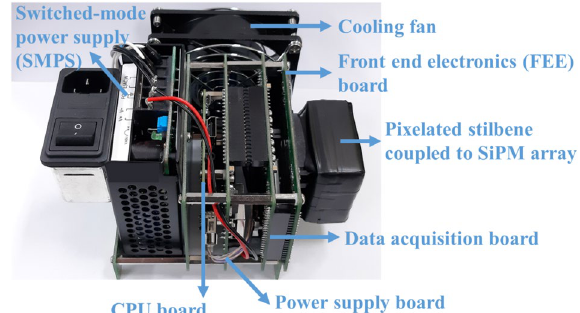
Figure 14. Hardware configuration for driving a SiPM-based pixelated stilbene array in which each of the electronic components is identified as well as the coupling to the stilbene and SiPM.